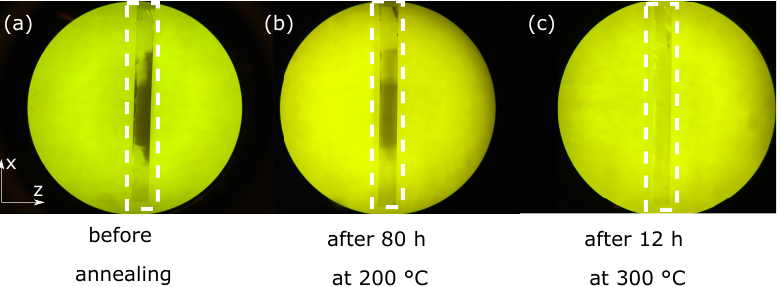
Figure 3. Microscope images of gray-tracked KTP samples for different annealing steps. The sample is shown in the white dashed box. We illuminated the sample with a green light source from the back side of the sample. In ( a ), we show the gray-tracked sample before annealing, in ( b ) the annealed sample after 80 h at 200 ◦ C and in ( c ) the sample, annealed for 12 h at 300 ◦ C.